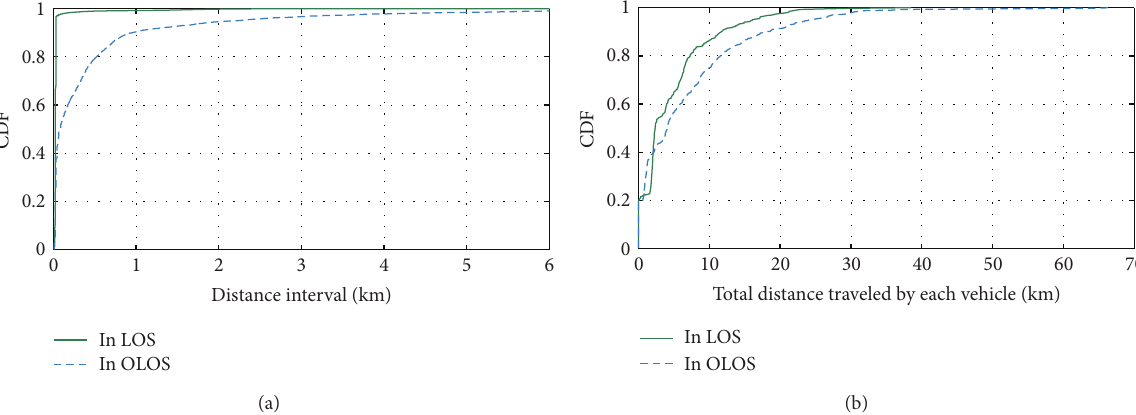
Figure 6: CDFs of (a) the LOS and OLOS intervals for all vehicles and (b) the total distance traveled in the LOS and OLOS by all vehicles.